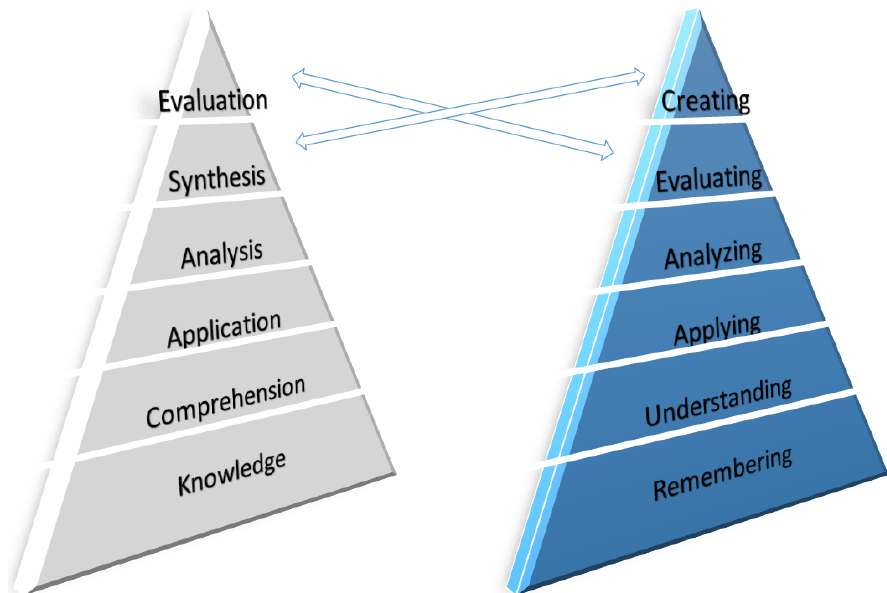
Figure 7. Bloom’s taxonomy versus the revised version according to [18].